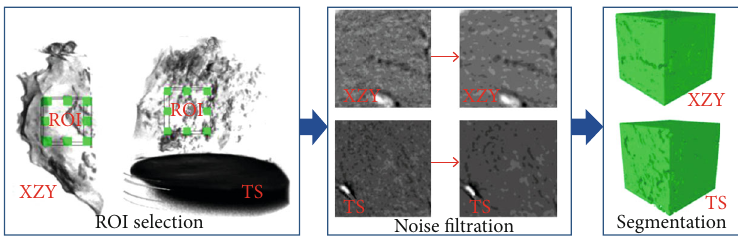
Figure 2: Flowchart of synchrotron radiation nano-CT images processing. ROI size is 200 × 200 × 200voxels . Voxel size is 0 : 01459 × 0 : 01459 × 0 : 01459 μ m . XZY represents sample from Xinzhouyao coal mine, and TS represents sample from Tangshan coal mine.